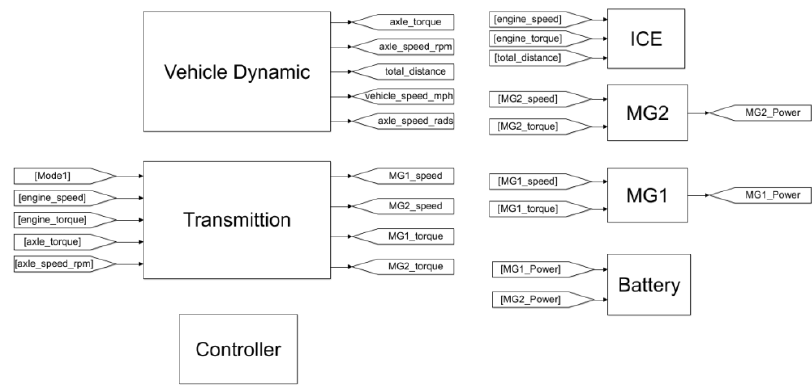
Figure 1. Simulink model of two-mode power-split hybrid system.